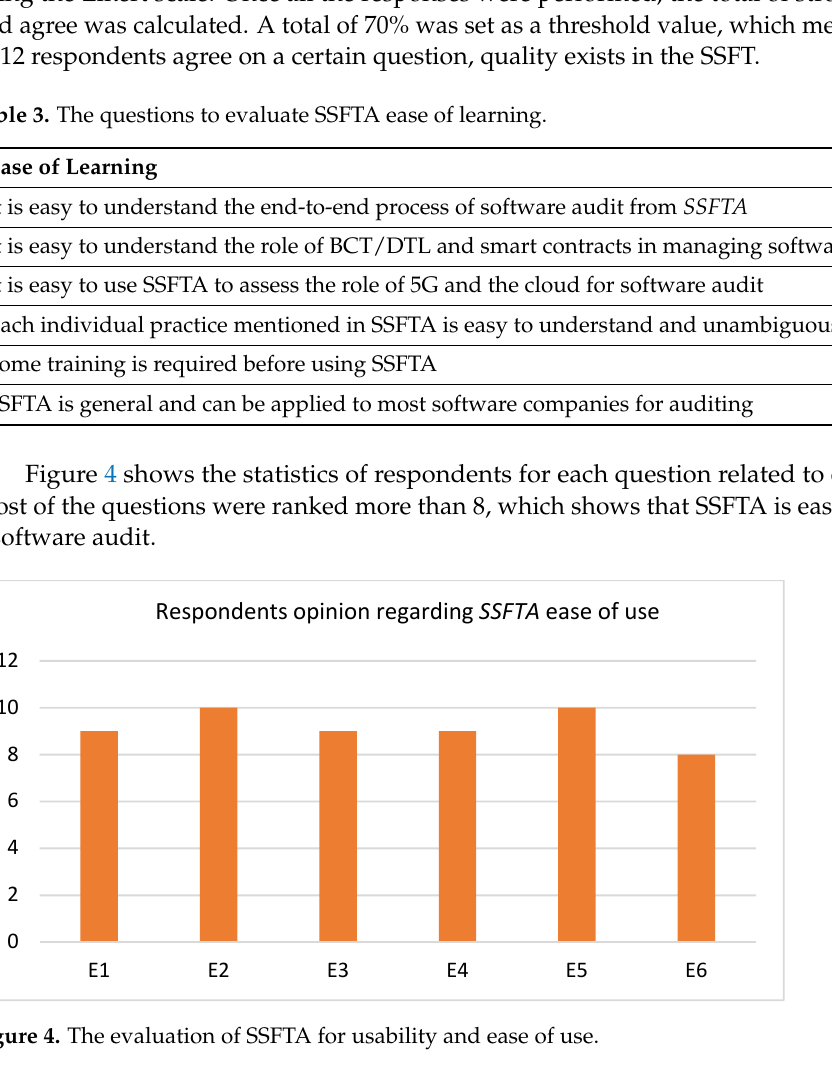
Table 4. The questions to evaluate SSFTA secure auditing characteristics .